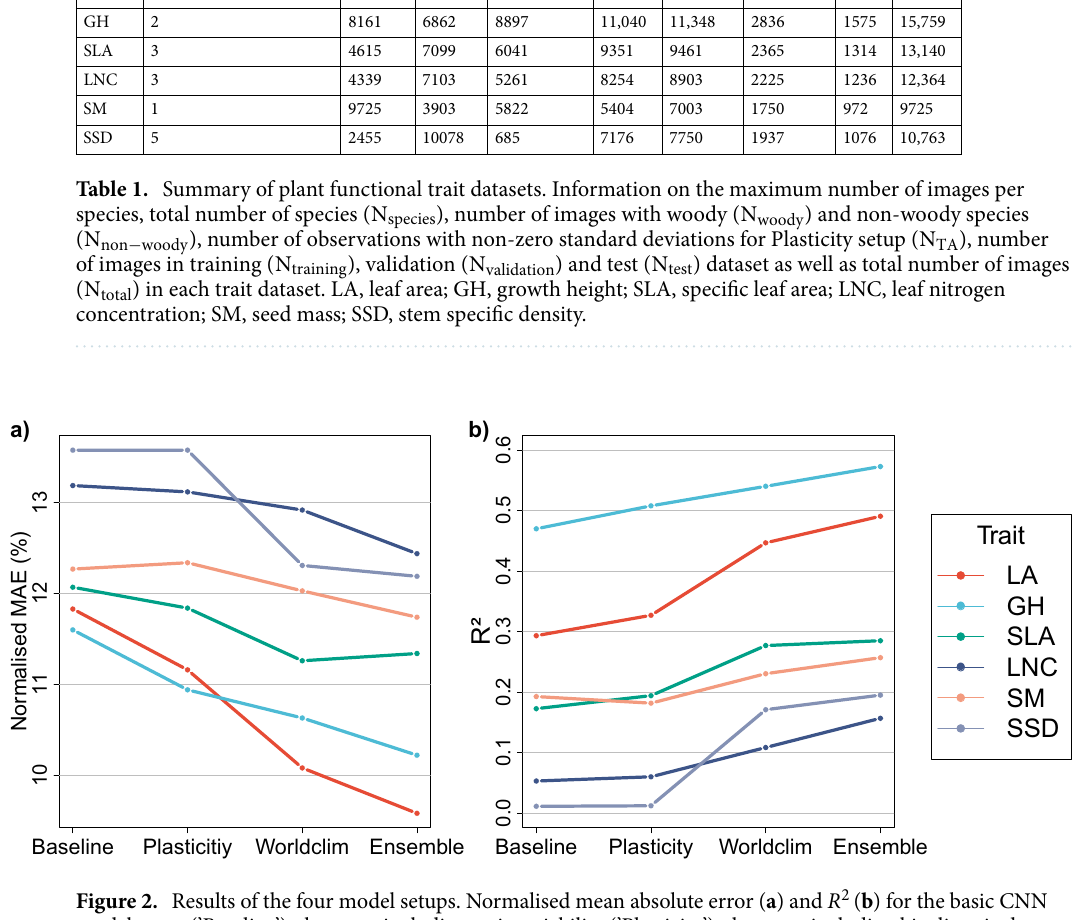
Fig. 2, Supplementary Table 2). The explained variance of the linear fit did not exceed 5% for SSD and LNC, but reached up to 47% for GH. Accounting for the intra-specific variability of traits by providing a distribution of trait values instead of a single mean value for each species (‘Plasticity’ setup) generally improved predictive performance with the exception of SM, increasing the explained variance by up to 3.79%-points (GH). Adding knowledge on the local climate of a photograph’s location (’Worldclim’ setup) generally increased the predictive performance. Its effect on R 2 was higher on LA, SLA and SSD (between approx. + 8 and + 16 %-points) than on GH, LNC and SM (between approx. + 3 and + 5 %-points). Furthermore, the ’Ensemble’ setup, in which we aver- aged the predictions of three common CNN architectures, generally increased R 2 , yielding a rise of more than 4%-points in explained variance for LA and LNC. The results of a threefold cross-validation based on the ensemble models revealed that the traits characterizing leaf form or habitus - GH and LA - demonstrated the lowest NMAE (9.91% and 9.92%; for prediction errors in original unit see Supplementary Table 3) and highest R 2 (.58 and .45; Fig. 3), whereas the traits related to tissue constituents, LNC and SSD, ranked lowest (11.71% and 11.98%; .16 and .2). Model performance vs. data heterogeneity. The assessment of the predictive performance by visual interpretation of 200 independent images per trait regarding the distance of the photographer to the target spe- cies (‘image-target distance’) showed that images with the longest distance attained 7.6%, whereas most images showed the shortest distance (63.5%; Fig. 4). Additionally, the vast majority of the images (92.9%) expressed a